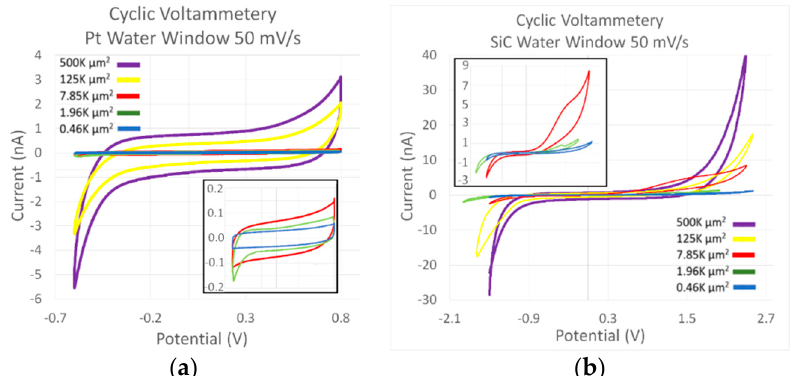
Figure 4. ( a ) CV plot showing a single curve from the cyclic voltammetry evaluation of a select 4H-SiC electrode. The curves were bounded at the potentials typically used for platinum or iridium electrodes of − 0.6 V and 0.8 V. The inset shows detail for the three smallest electrodes. ( b ) A plot of the second CV curve from a select electrode. The ramp rate was the same as for ( a ), but the potential limits were extended to the onset of a large current flux. All tests were performed in PBS that was naturally aerated (i.e., no application of gas bubbling) and possessed a pH of